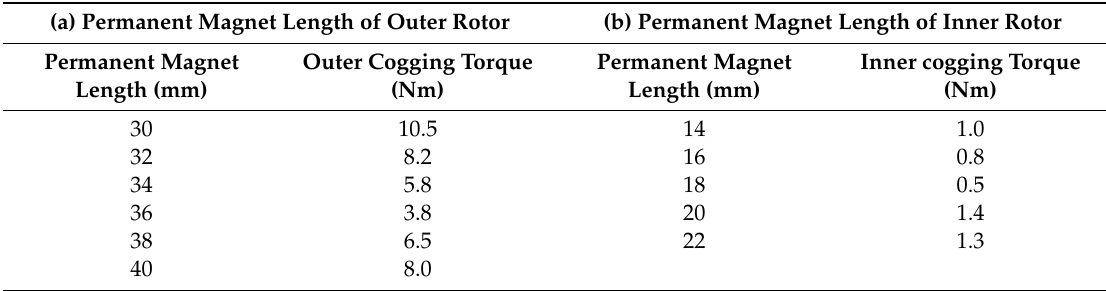
Table 2. Cogging torque according to the dual rotor magnet